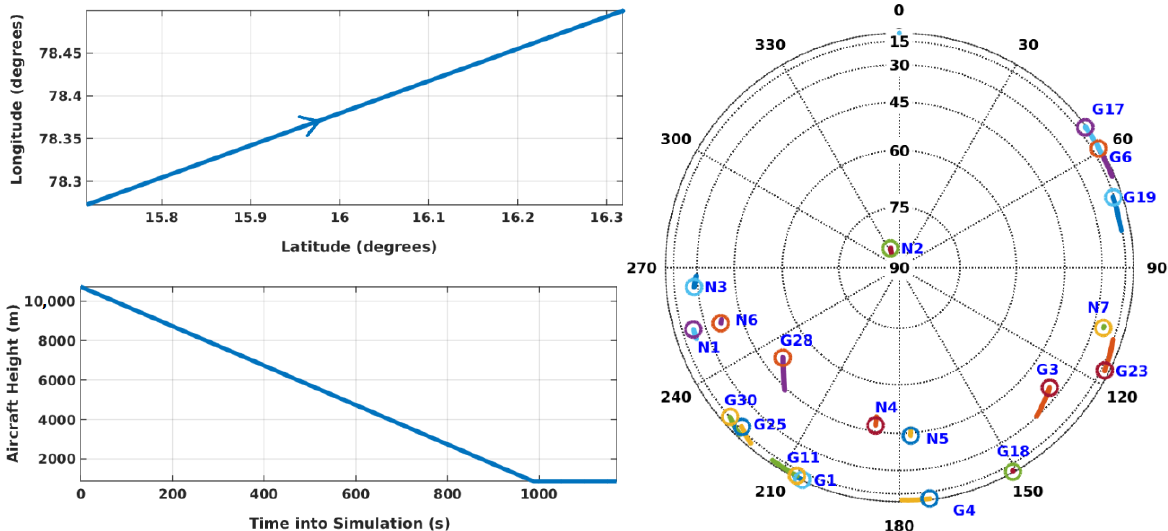
Figure 5. Simulated aircraft trajectory and skyplot of visible GPS and NavIC satellites. Aircraft height is shown above the WGS84 reference ellipsoid. In the skyplot, the circle marks the final position of a satellite in the trace. ‘G’ is for GPS, and ‘N’ is for NavIC.